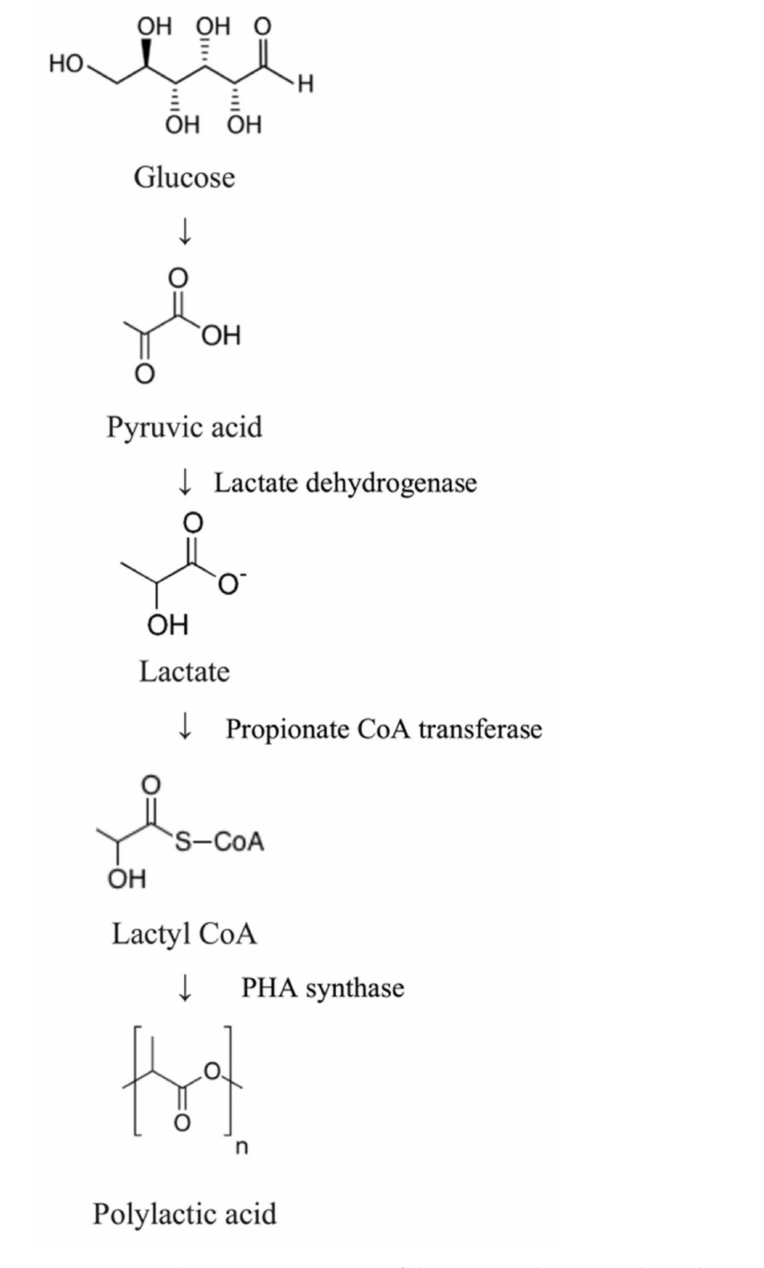
Figure 14. A schematic presentation of the PLA production pathway by recombinant E. coli . Adapted with permission from a report by Jung and Lee [304]. Copyright © 2021,